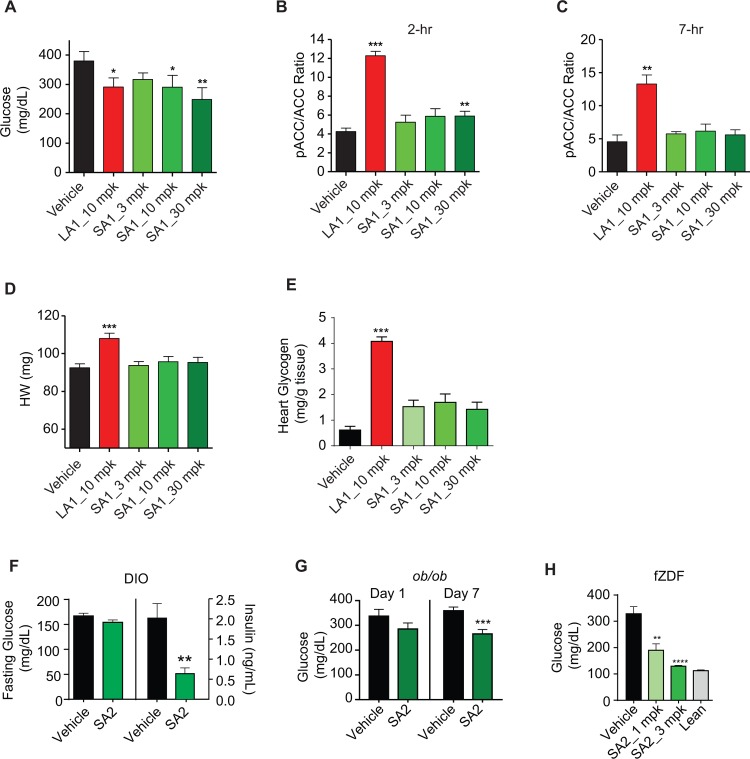
Short-acting AMPK activators reduce hyperglycemia, at trough, without inducing cardiac hypertrophy in rodent models of diabetes; db/db (A-E), eDIO (F), and ob/ob (G) mice and fZDF (H) rats. (A) Glucose measured at trough (approximately 24 hours post last dose) on day 12 of 8 week old male db/db mice treated with vehicle, LA1, and SA1 (n = 10). (B–C) pACC/ACC ratio of skeletal muscle at 2h (n = 7) and 7h (n = 3) post dose on day 14. (D) Heart weight of db/db mice on day 14. (E) Heart glycogen content of db/db mice on day 14. (F). Plasma levels of fasting glucose and insulin in 26 week old eDIO mice (average body weight of 48 grams) treated with vehicle or SA2 (3 mg/kg, QD, PO) for 4 weeks (n = 7). (G) Glucose levels of 7 week old ob/ob mice at 24h post compound administration on day 1 and day 7. (H) Glucose levels at 24h post dose (trough) after 21-day treatment of SA2 (1 and 3 mpk, QD, PO) in 8 week old fZDF (n = 10) and lean control rats (n = 6). Data are represented as mean ± SEM. *p < 0.05, **p < 0. 01, *** p < 0.001 relative to vehicle.